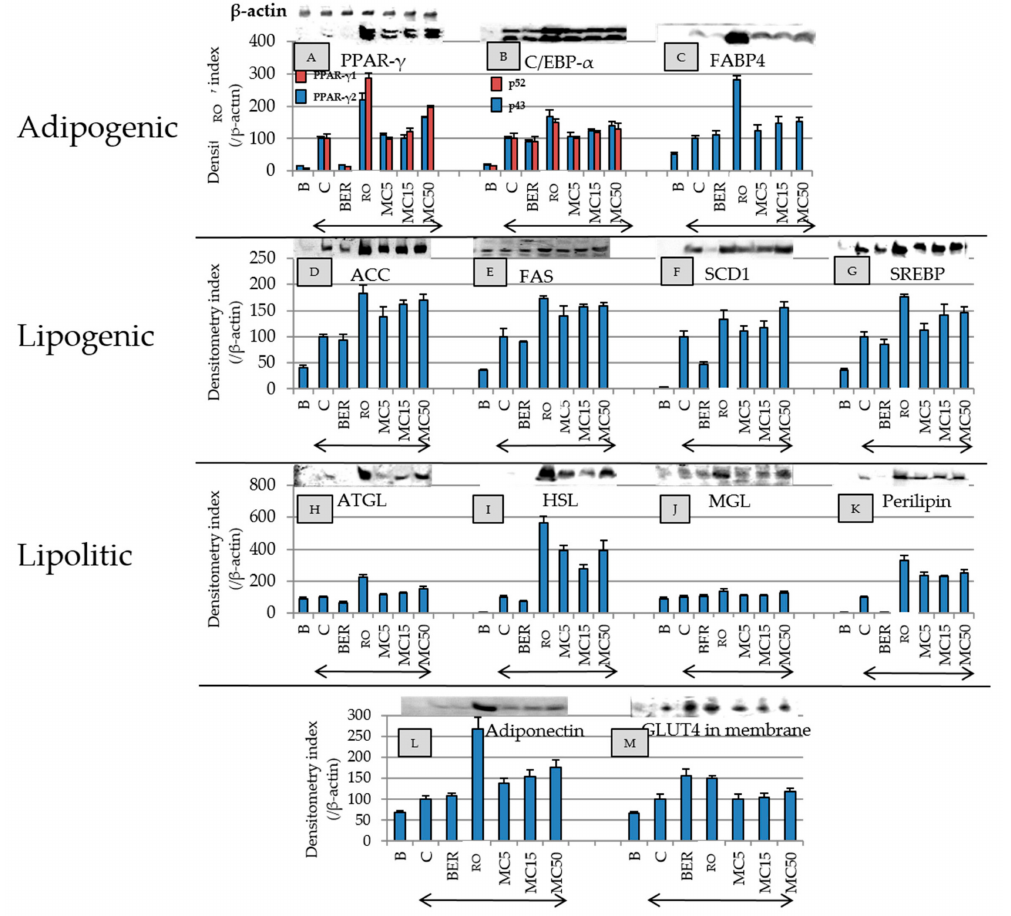
Figure 5. The e ff ects of each compound on adipogenesis-related proteins, adiponectin, and GLUT4 levels in 3T3-L1 cells on day 8. Since all the same samples were used and meansurements were performed using 13 types of primary antibodies, only one β -actin image was shown. Protein levels were measured by electroblotting. B (Black): Undi ff erentiated cells without the addition of the MDI, C (Control): cells with the addition of the MDI, BER: cells with MDI and berberine (2.7 nM), and RO: cells with MDI and rosiglitazone (100 nM). The number with MC indicate the concentration ( µ M). Arrows indicate the addition of the MDI mixture. Data are presented as the mean ± SD from three independent experiments. The test results of the significance of protein expression levels are summarized in Table S2 of the Supplemetary